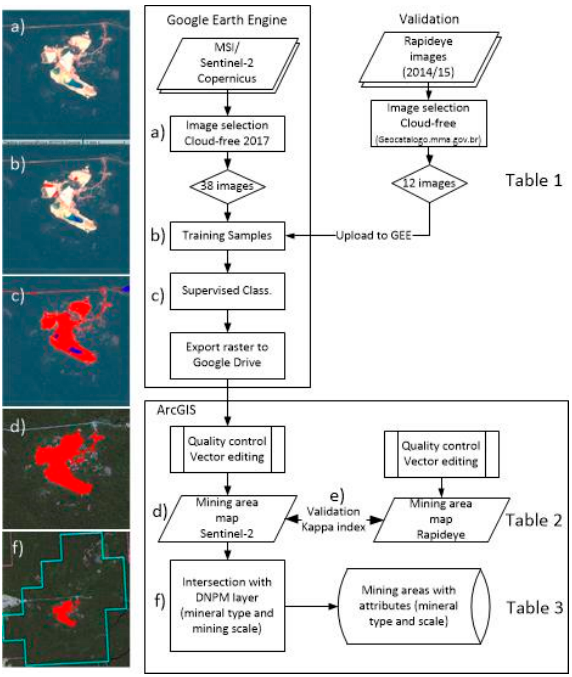
Figure 2. Flowchart with examples of steps taken to address objective 1 ( a – e ) and objective 2 ( f ). In GEE (Google Earth Engine): ( a ) Images selection; ( b ) training samples; ( c ) supervised classification